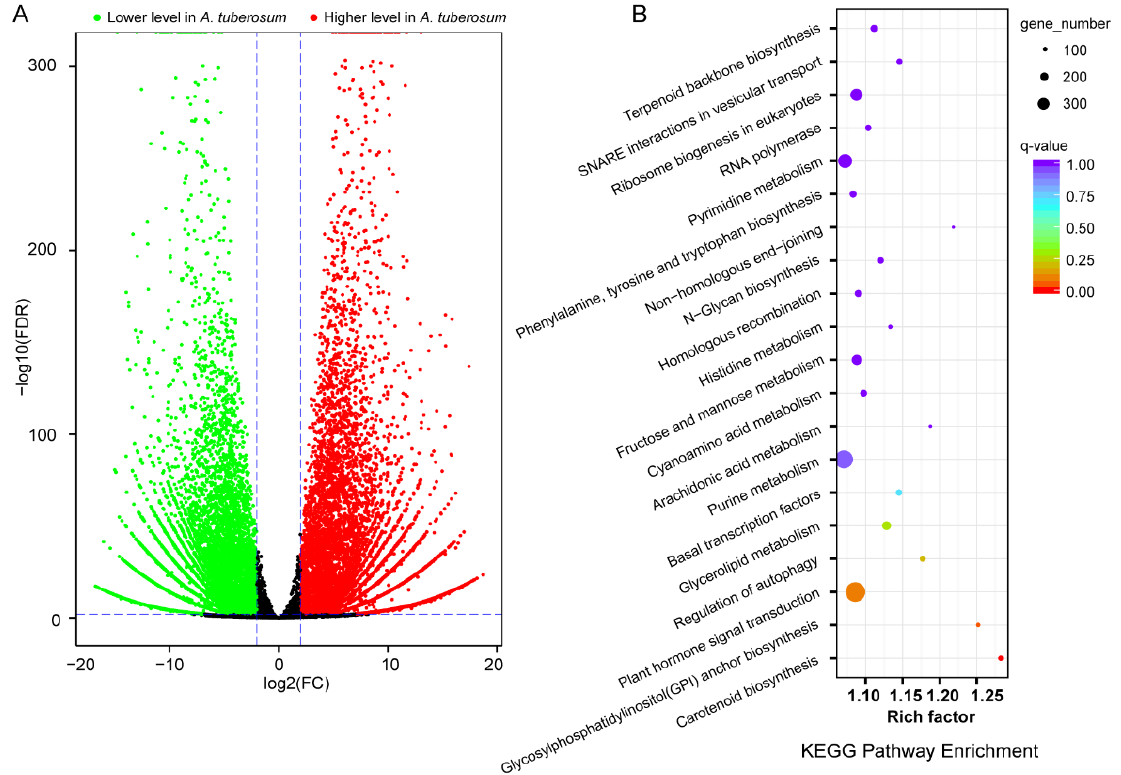
Figure 4. Profile of differentially expressed genes (DEGs) in comparative transcriptome analysis ( A. tuberosum vs. A. hookeri .). ( A ) Volcano plot showing statistical significance of DEGs. ( B ) KEGG enrichment analysis. Table 2. Top 20 GO terms in GO enrichment analysis of DEGs.